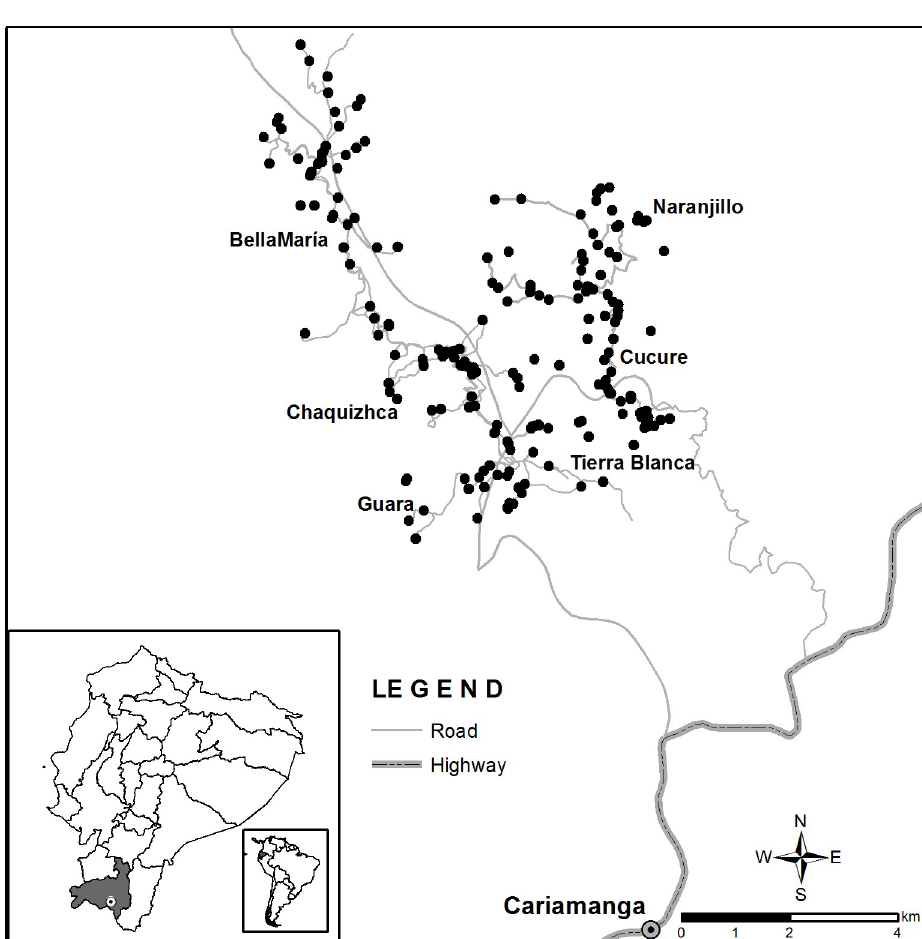
Fig 1. Map of the Communities in relation to nearest city of 25,000